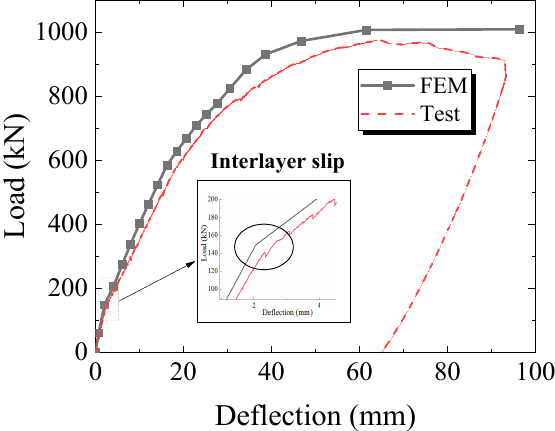
Figure 17. Comparison of numerical and experimental load–deflection curves at mid-span.